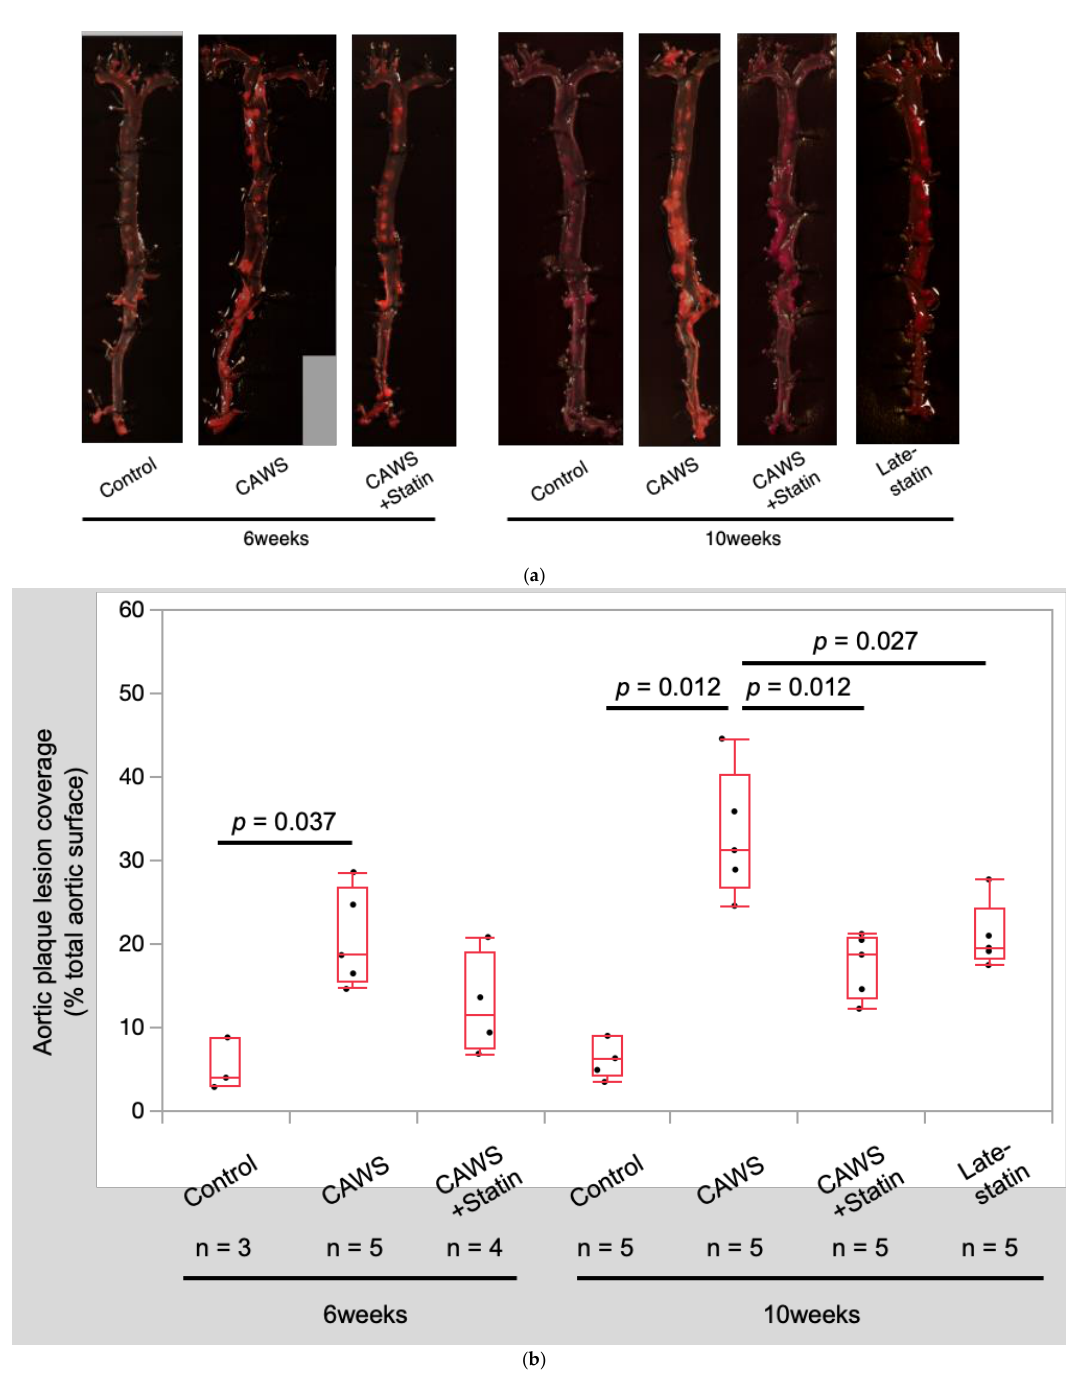
Figure 2. Histological findings of aortic plaque lesion coverage. The paraformaldehyde-fixed aorta was stained with Oil Red O. Quantification of aortic plaque lesion coverage area ratios on the entire aortic surface was performed in Apo E-/- mice. The plaque area was significantly higher in the CAWS mice than in statin-treated mice. Interestingly, the late-statin group showed a similar reduction in the aortic plaque area as the statin group. Total aortic plaque coverage ratios were calculated and compared between groups. Area ratios were expressed as percentages. CAWS significantly promoted atherosclerosis at both 6 and 10 weeks after administration. In both the late-statin and CAWS+statin groups at 10 weeks, statins significantly inhibited atherosclerosis. The inhibitory effects were comparable between both groups. ( a ) Quantification of aortic plaque lesion coverage area ratios on the entire aortic surface. ( b ) Total aortic plaque coverage